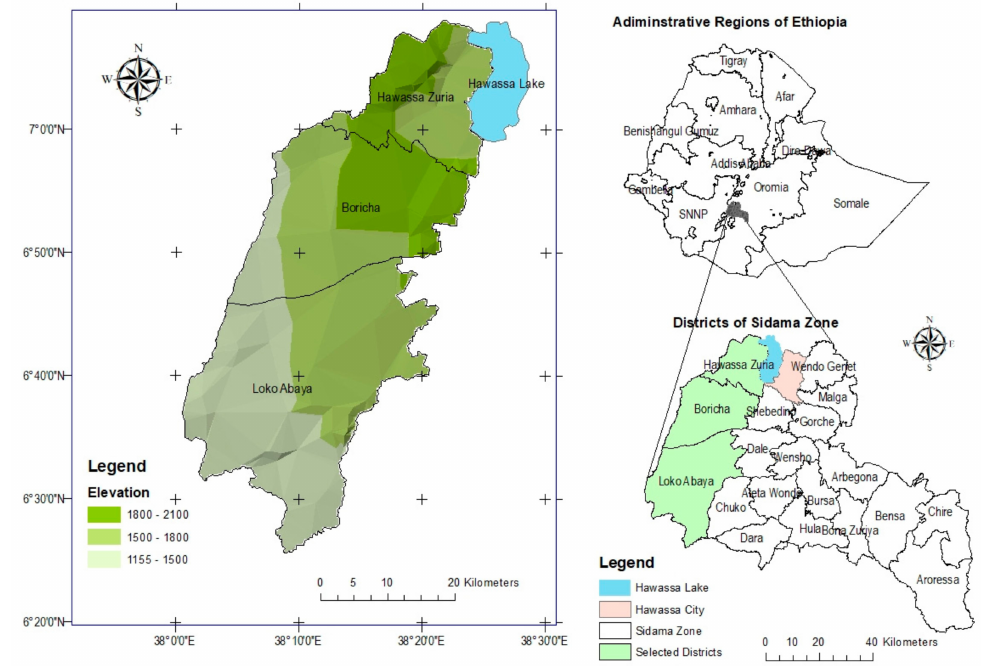
Figure 1. The geographic location of the study